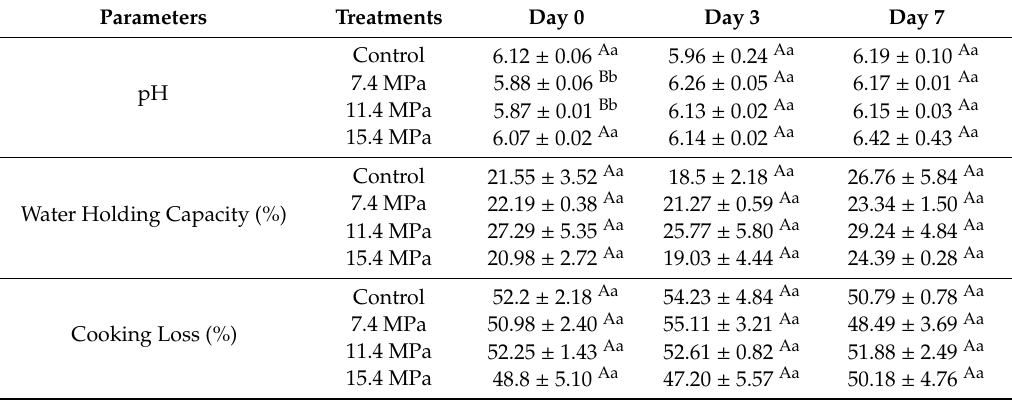
Table 3. E ff ects of three levels (7.4, 11.4 and 15.4 MPa) of SC-CO 2 at 31 ◦ C for 10 min on the pH, water holding capacity, and cooking loss of chicken meat stored at 4 ± 1 ◦ C for seven